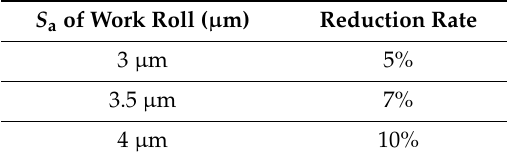
Table 1. Working condition